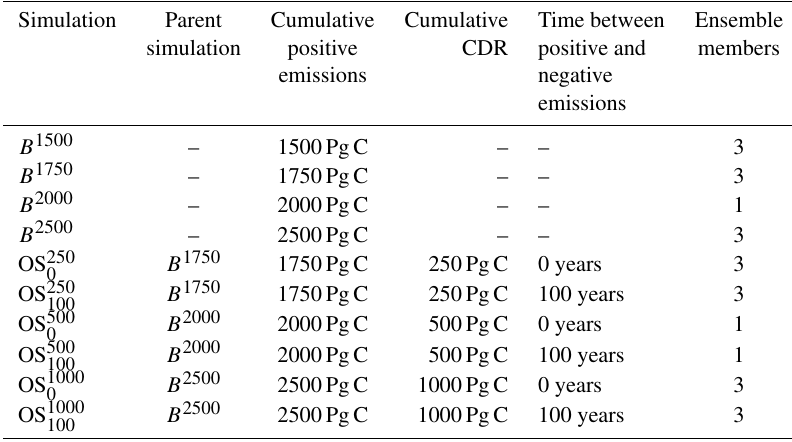
Table 1. Overview of simulations without ( B ) and with (OS) overshoot. Simulation Parent Cumulative Cumulative Time between Ensemble simulation positive CDR positive and members emissions negative emissions B 1500 – 1500PgC – – 3 B 1750 – 1750PgC – – 3 – 2000PgC – – 1 B 2500 – 2500PgC – – 3 B 1750 1750PgC OS 250 0